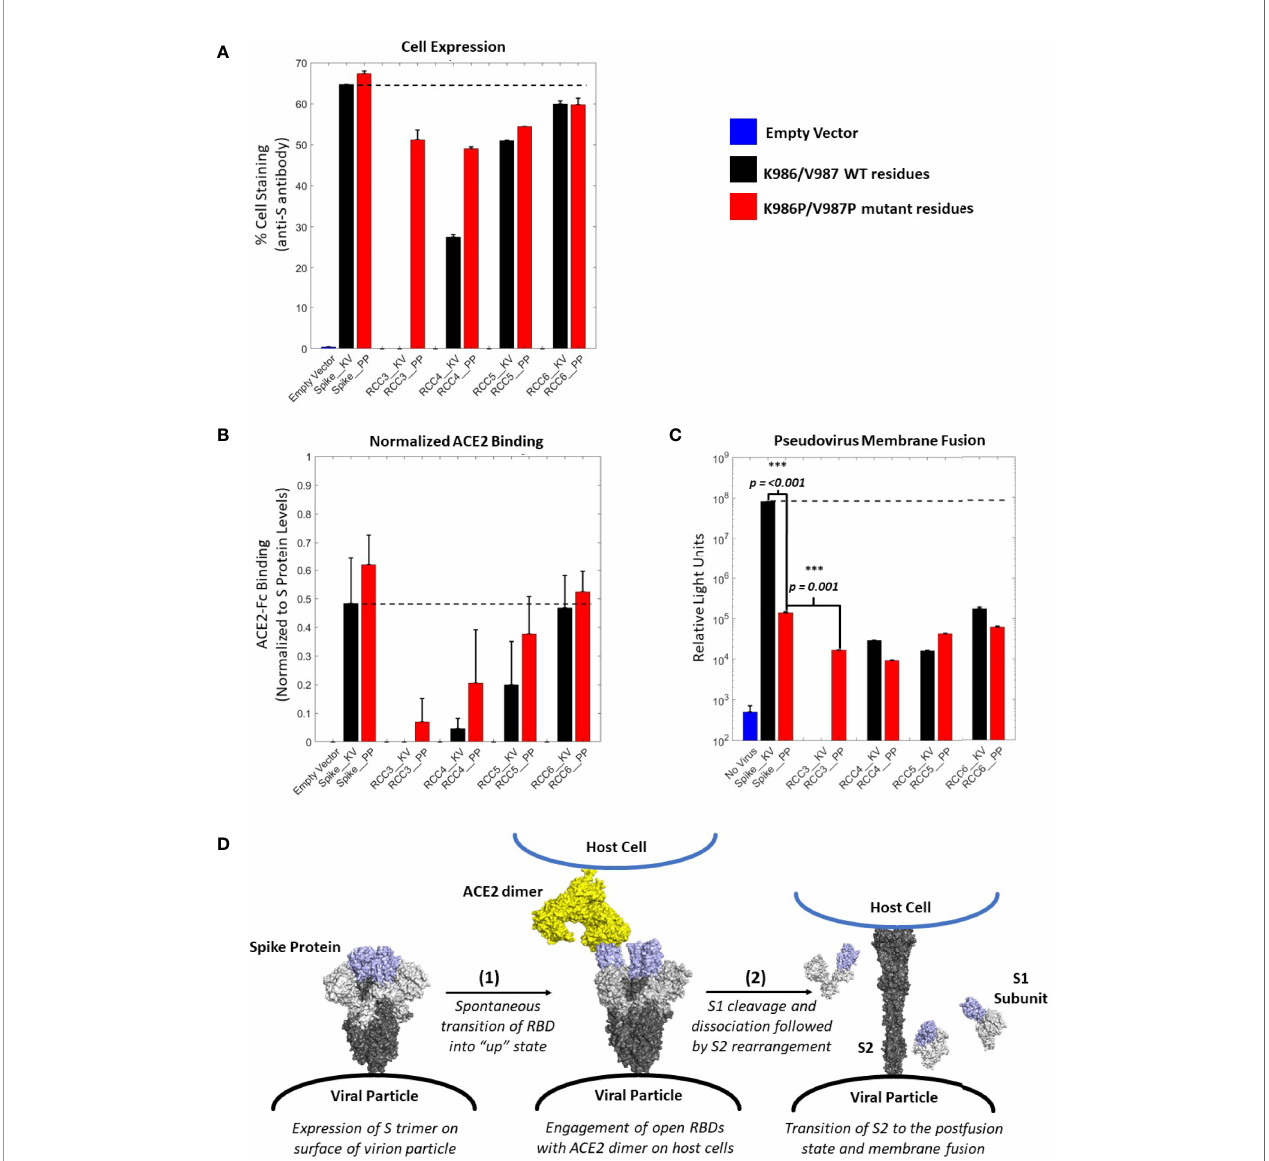
FIGURE 4 | ACE2 Binding and pseudovirus inhibition. Expression of Spike trimer on cell surface of HEK293 cells as determined by staining with anti-S protein antibody (A) . Normalized ACE2 binding of cells expressing Spike constructs as determined by staining with ACE2-Fc antigen (B) . Luciferase activity of HEK293 cells infected with pseudovirus particles displaying Spike constructs with a Luciferase reporter gene. An unpaired t-test indicates the Spike_PP activity is signi fi cantly inhibited compared to Spike_KV. Additionally, p-values indicate a signi fi cant difference between Spike_PP and RCC3 as well (C) . Model of Spike trimer postfusion transition highlight two possible stages [(1) and (2)] for postfusion inhibition (modeled from PDB 6VSB and 6M3W) (6, 36) (D) . All experiments performed in triplicate with error bars denoting the standard deviation. Note: RCC3_KV design failed cloning assembly.